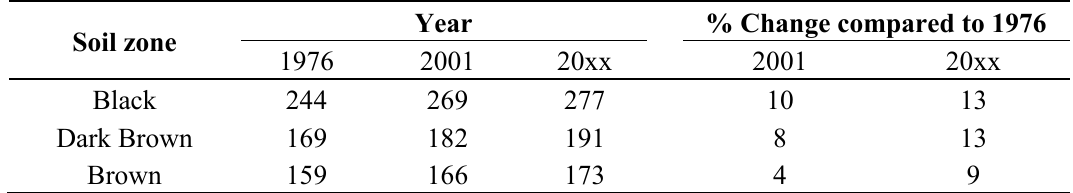
Table 3. Land-use weighted evapotranspiration (mm) during the growing season † in the three soil zones of the Canadian